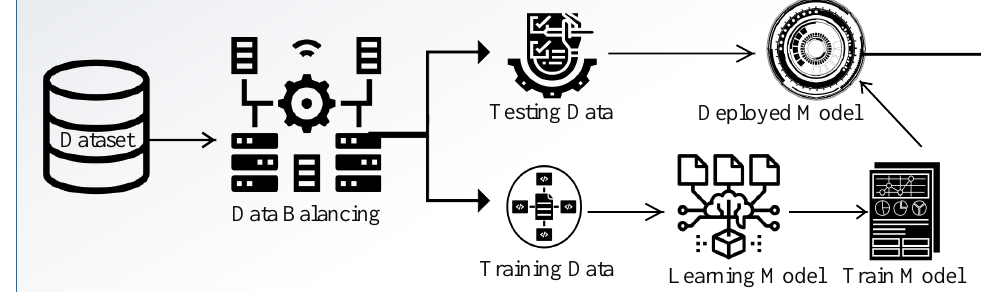
Figure 1. The proposed system mode of blockchain and